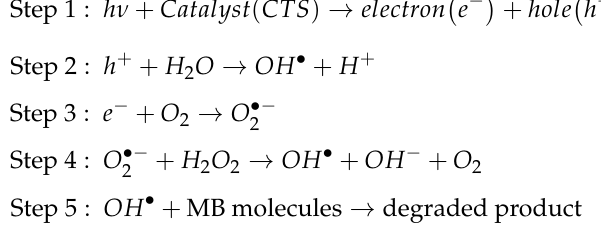
Table 1. The probable reaction phases are as